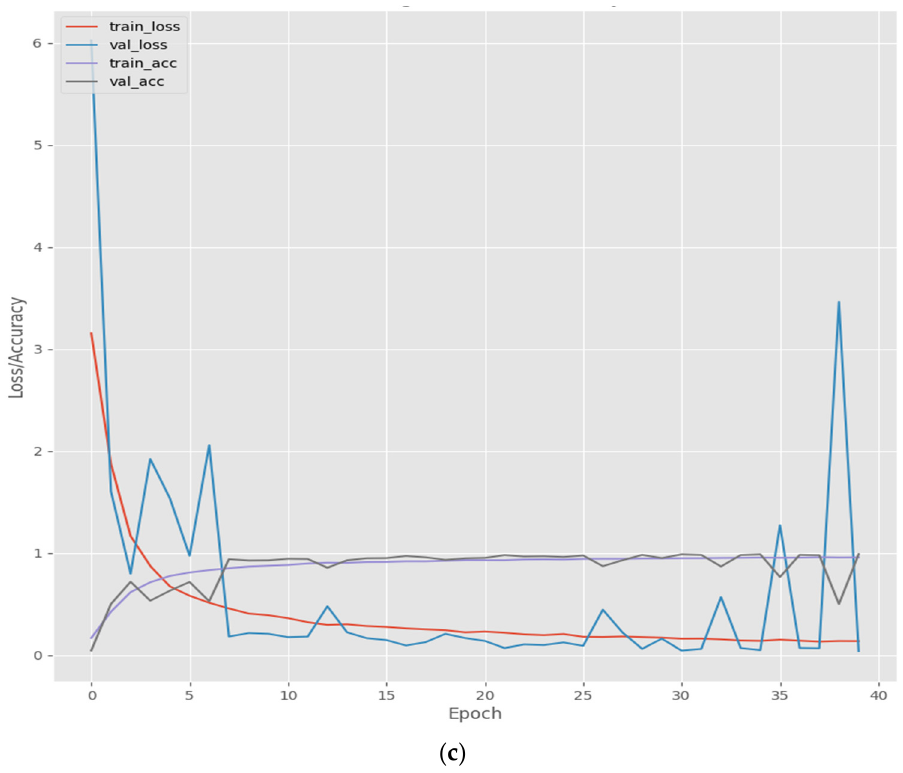
Figure 11. Analysis of the proposed model at 40 epochs with a batch size of 40: ( a ) precision, recall and F1 score of 24 classes; ( b ) confusion matrix; ( c ) accuracy and loss curve.